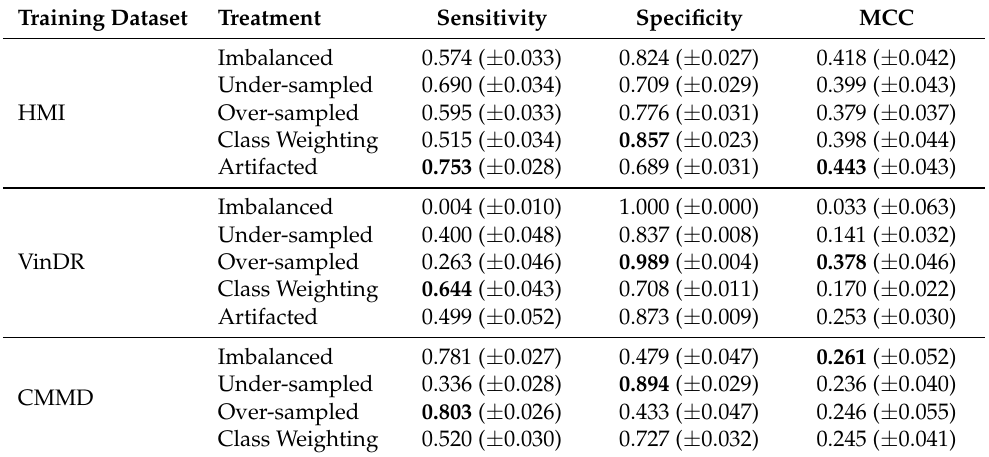
Table 3. Metrics ( ± standard error) at an operating point of 0.5, where the test set and training set come from the same distribution.